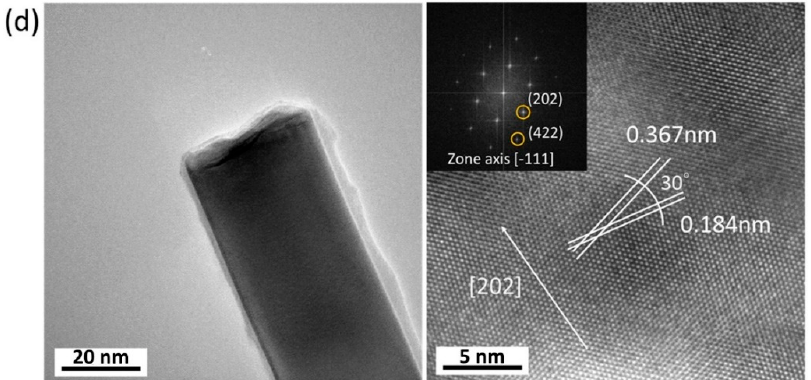
Figure 5. ( a ) XRD spectrums of β -FeSi 2 and FeSi at different growth temperatures. ( b ) XRD spectrums of β -FeSi 2 and FeSi at different ambient pressures. ( c , d ) Low-magnification TEM and HR-TEM images of FeSi and β -FeSi 2 nanowires (NWs). ( c ) FeSi nanowires grown at 1000 °C for 5 min. The inset shows the corresponding diffraction patterns of FeSi. ( d ) β -FeSi 2 nanowires grown at 850 °C for 2